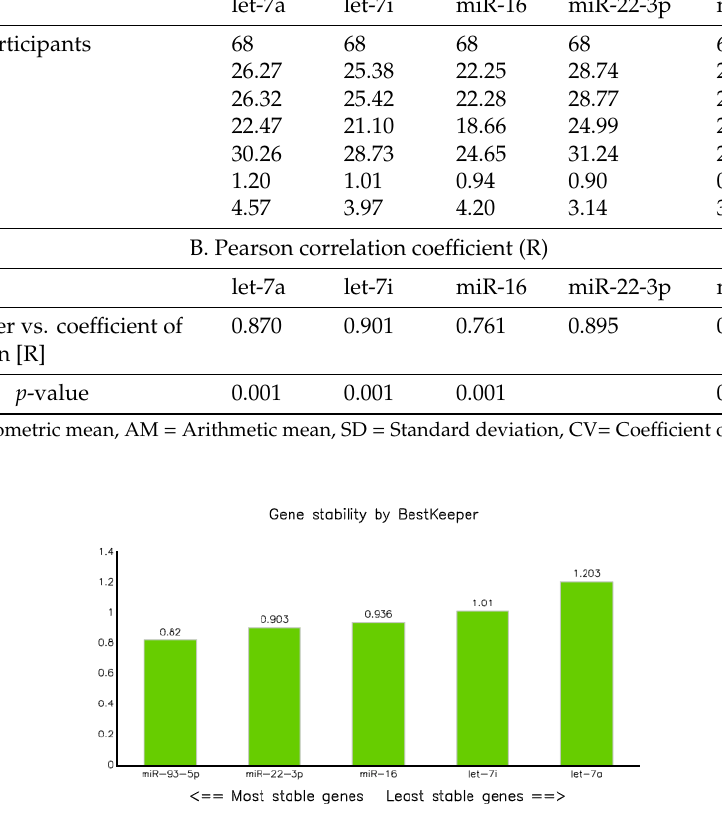
Table 6. Average standard deviation result of selected miRNAs calculated by Best Keeper